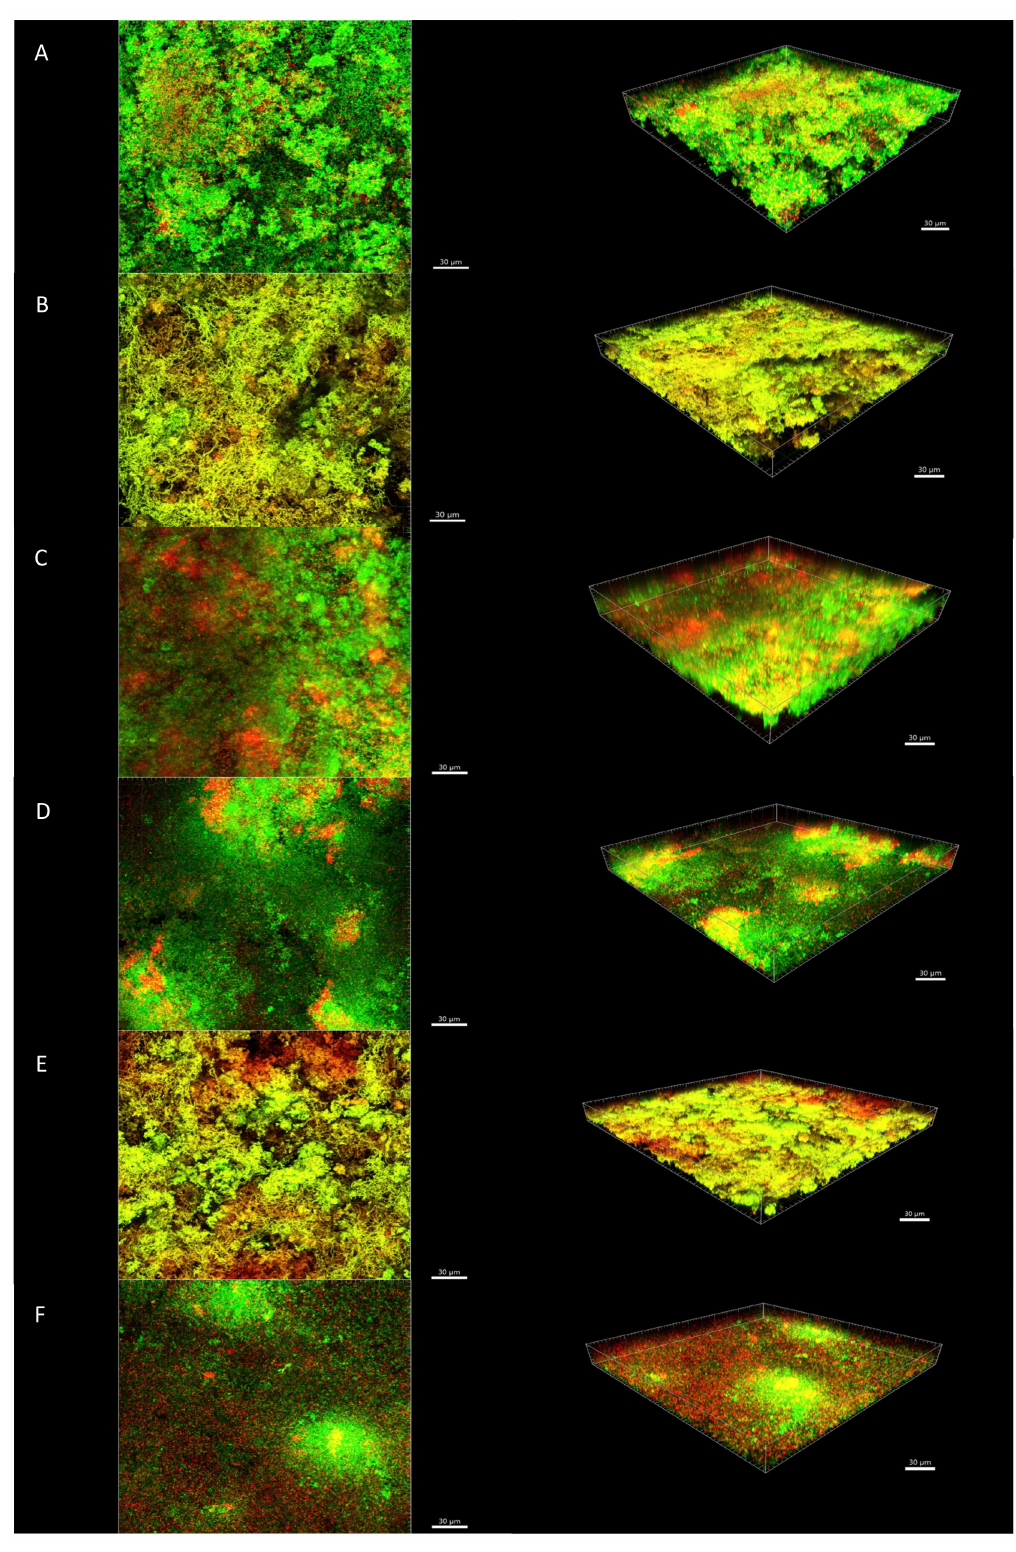
Figure 2. Confocal laser scanning microscopy images of in vitro biofilms after 5-min treatment. ( A ) Control group with no treatment; ( B ) 2% CHX; ( C ) eight D-AAs; ( D ) high-purity nisin; ( E ) high-purity nisin + 2% CHX; and ( F ) high-purity nisin + eight D-AAs. The biofilms were stained using the LIVE/DEAD Viability Kit; live cells appear green and dead cells red. Images represent the 3D reconstructions of the biofilms using the IMARIS 7.6.5 software (orthogonal and perspective views from left to right). Scale bar 30 µ